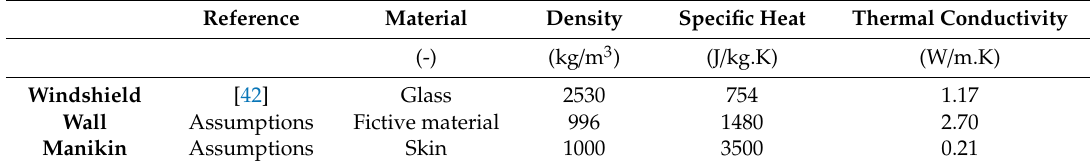
Table 6. Material properties of the vehicle cabin surfaces and the human